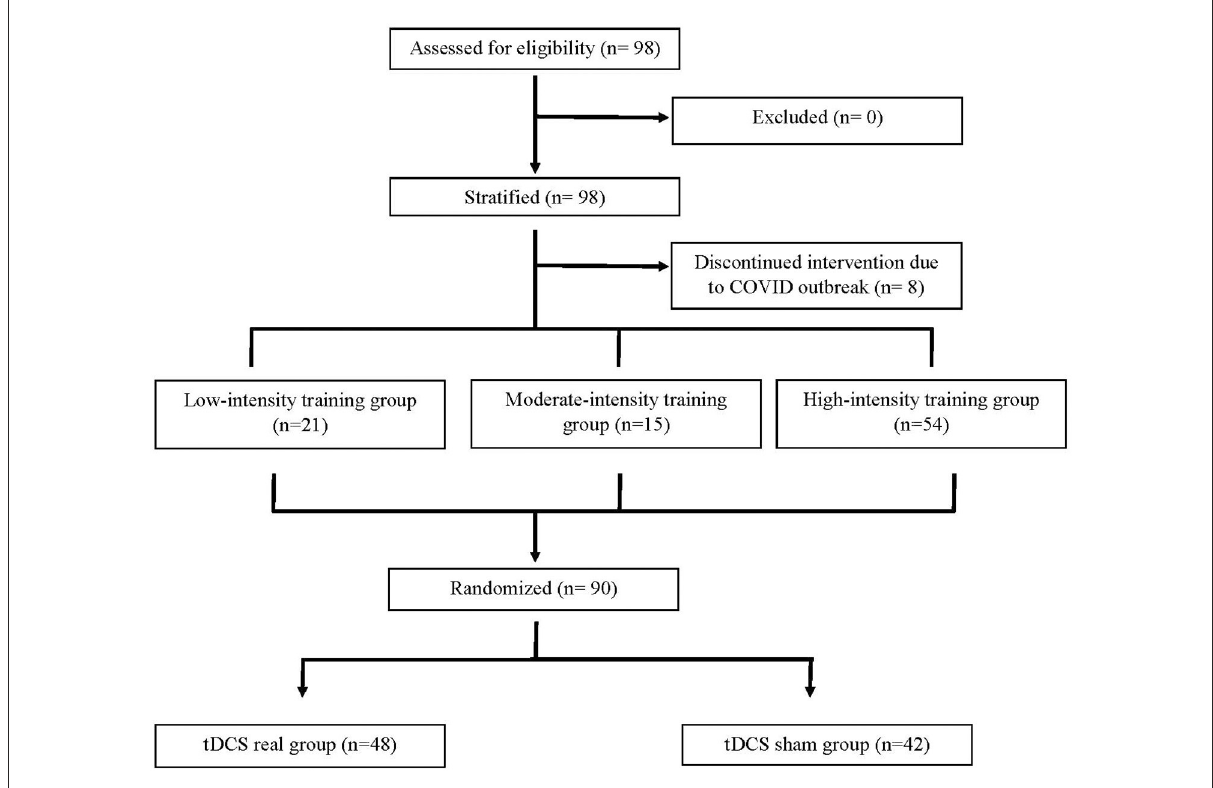
FIGURE1 Study flow